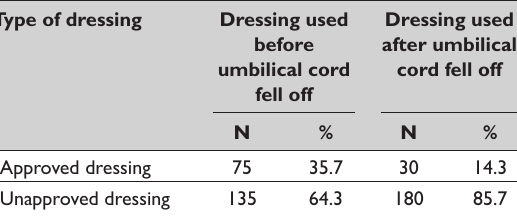
Table 2: Univariate analysis on type of dressing used before the umbilical cord fell off